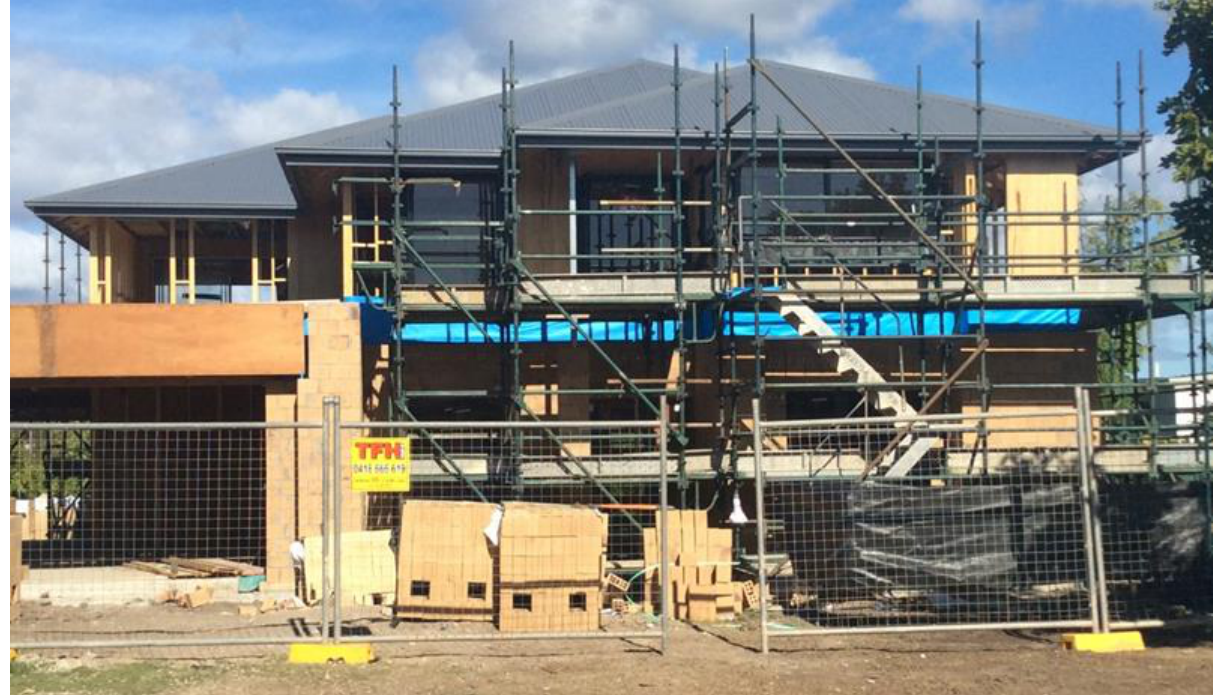
Figure 4: Traditional brick veneer